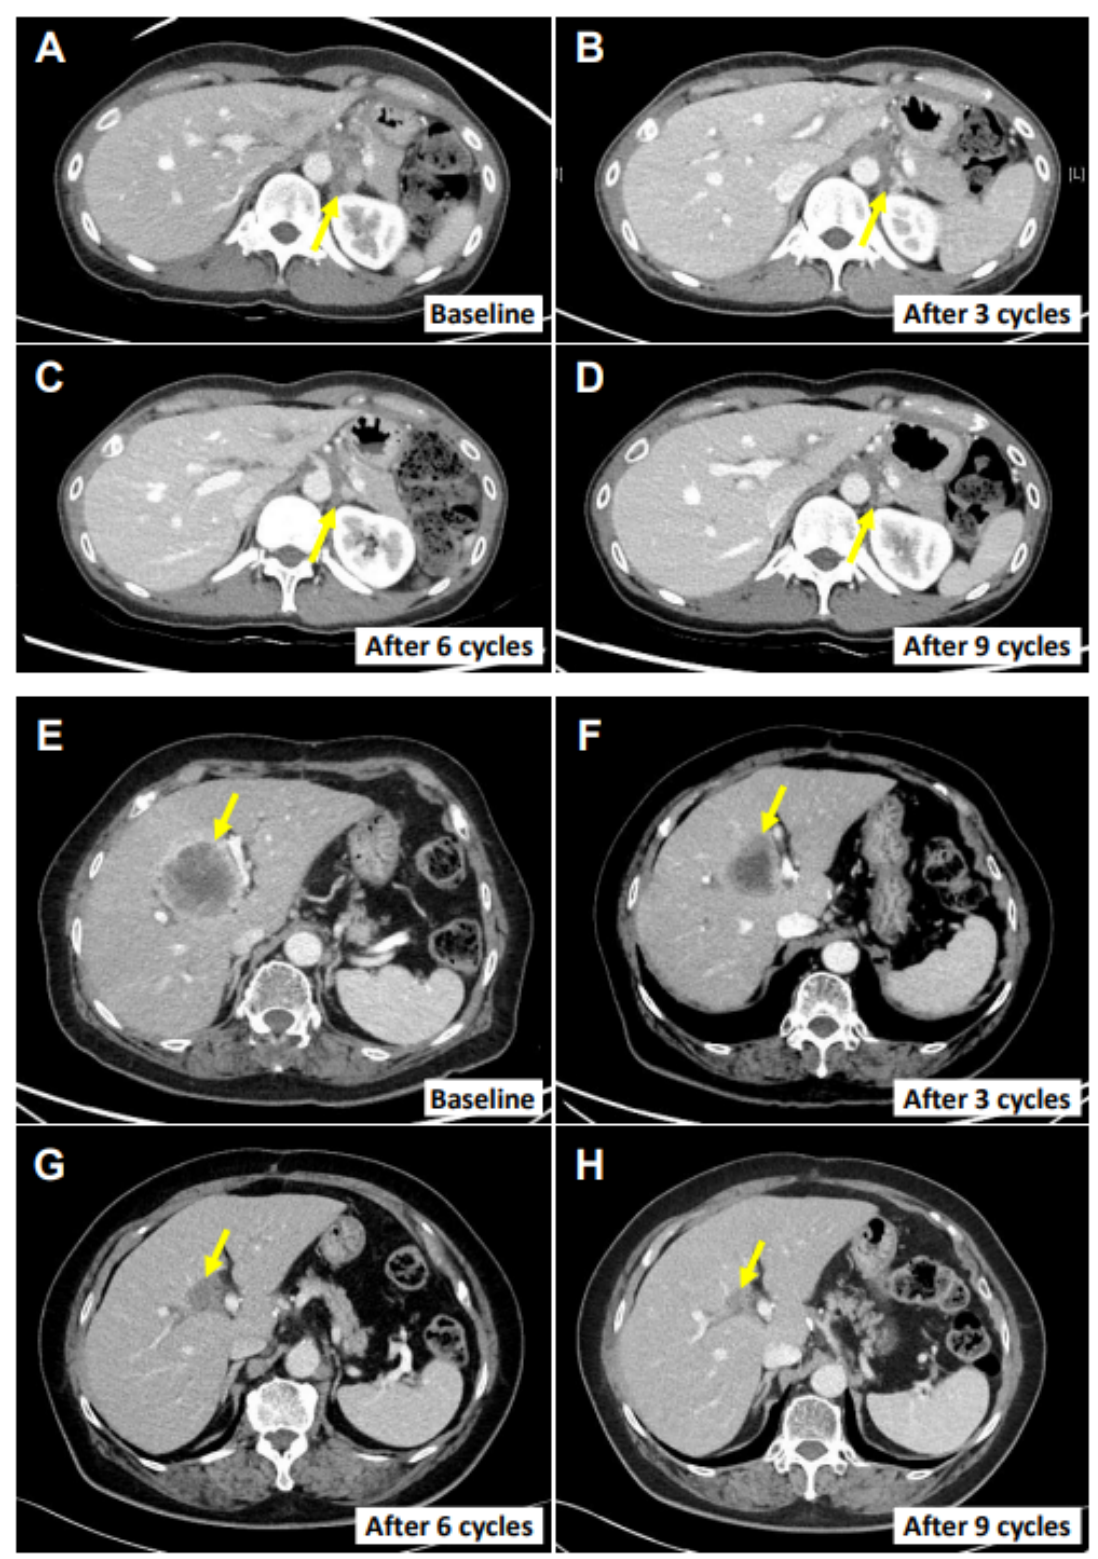
Figure 3. Cancer regression in two patients. CT images of the main tumor lesions at the baseline in each response evaluation. ( A – D ) Left infrarenal lymph node in patient E0107. ( E – H ) The main hepatic metastasis lesion in patient E0217. Yellow arrows indicate the target lesions. Response evaluations were performed after every three